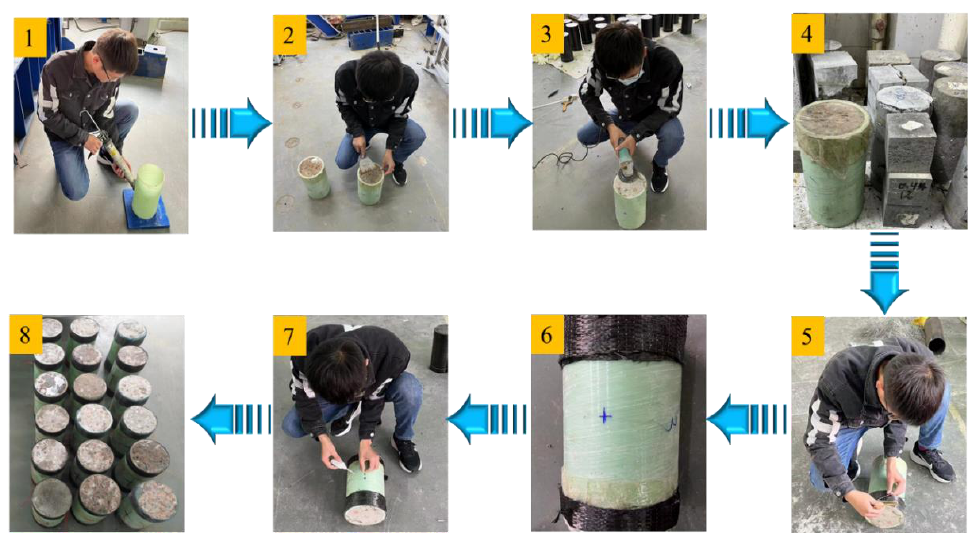
Figure 2. Specific fabrication process of specimen.